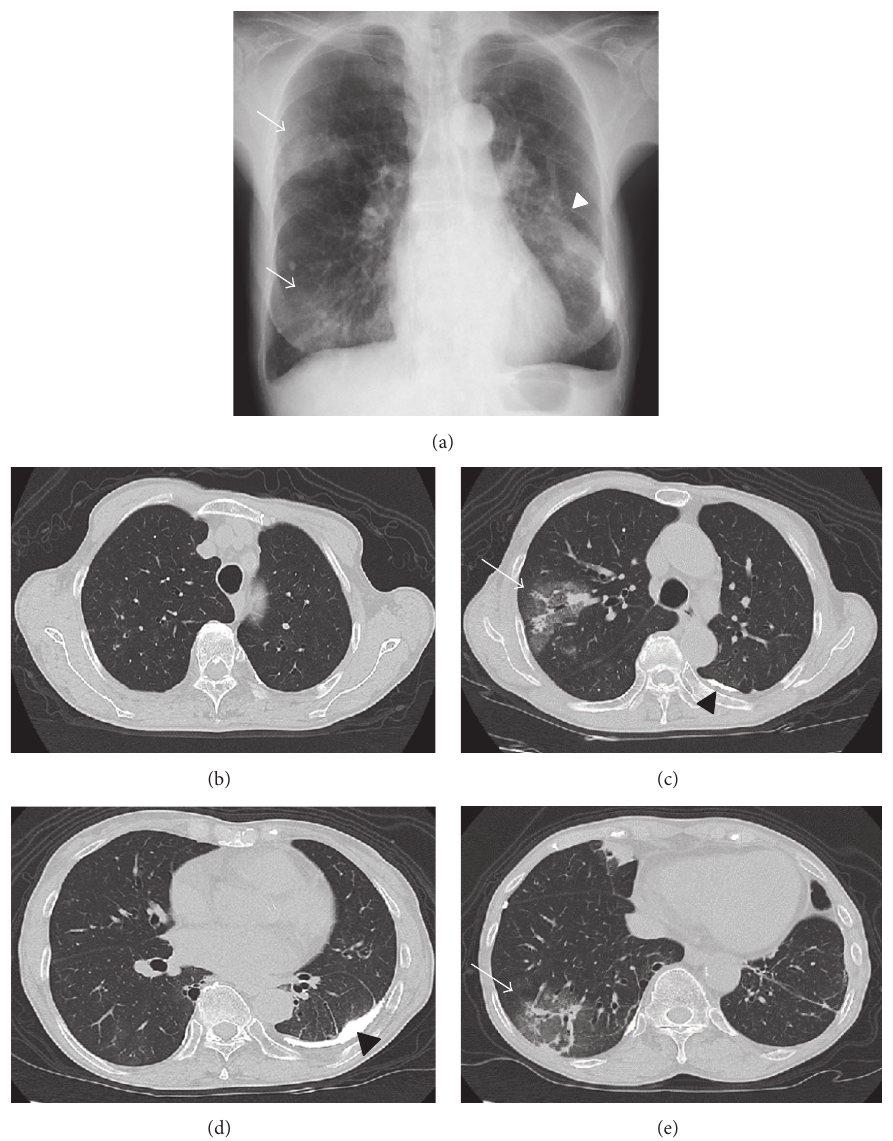
Figure 1: Findings on chest radiography and computed tomography. (a) Chest radiograph showing reticular shadows in the right middle and lower lung fields (arrow). Calcified lesions were seen in the left lung field (arrowhead). (b–e) Chest computed tomography (CT) showing segmental ground glass shadows in the upper and lower lobes of the right lung (arrow). The left pleura shows thickening with calcification